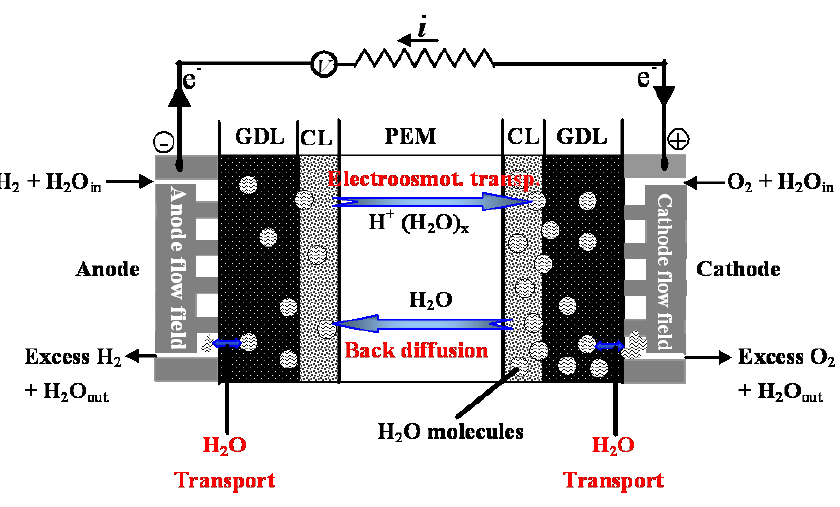
Figure 2. The water transport mechanism inside a